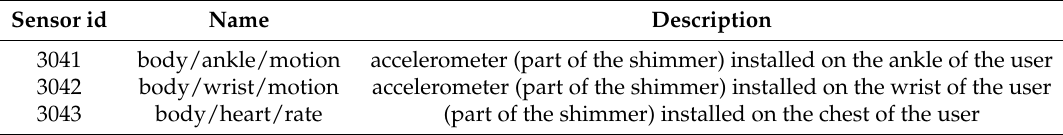
Table 3. Wearable sensors used for the bedroom data set.